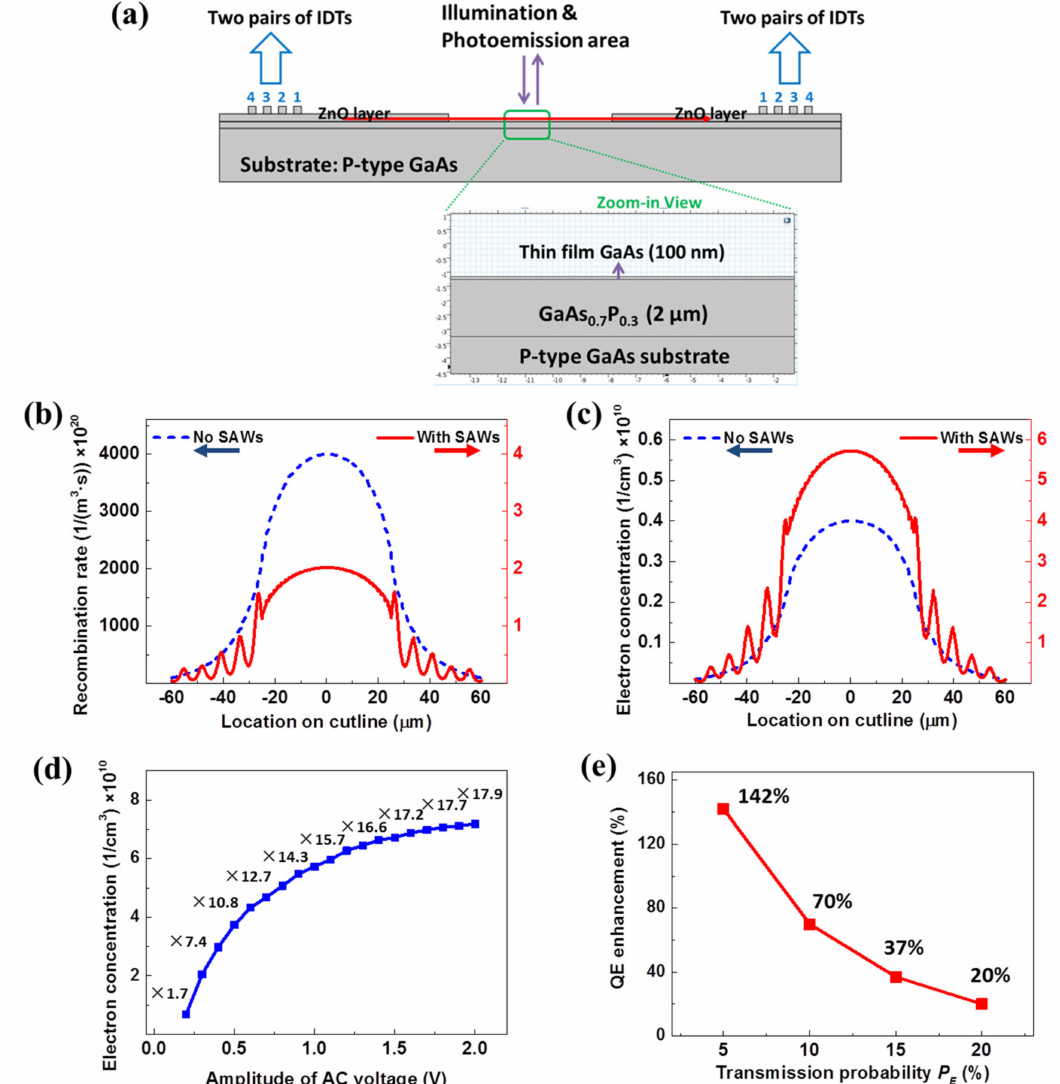
Figure 3. ( a ) Simulation structure of thin film GaAs with IDTs. ( b ) Comparison of recombination rates in GaAs thin film with and without SAWs ( V 0 = 1.0 V). ( c ) Comparison of surface electron concentrations with and without SAWs ( V 0 = 1.0 V). ( d ) Increase of electron concentrations caused by SAWs for di ff erent amplitudes of AC voltage. ( e ) Enhancement of QE caused by SAWs under di ff erent transmission probability P E